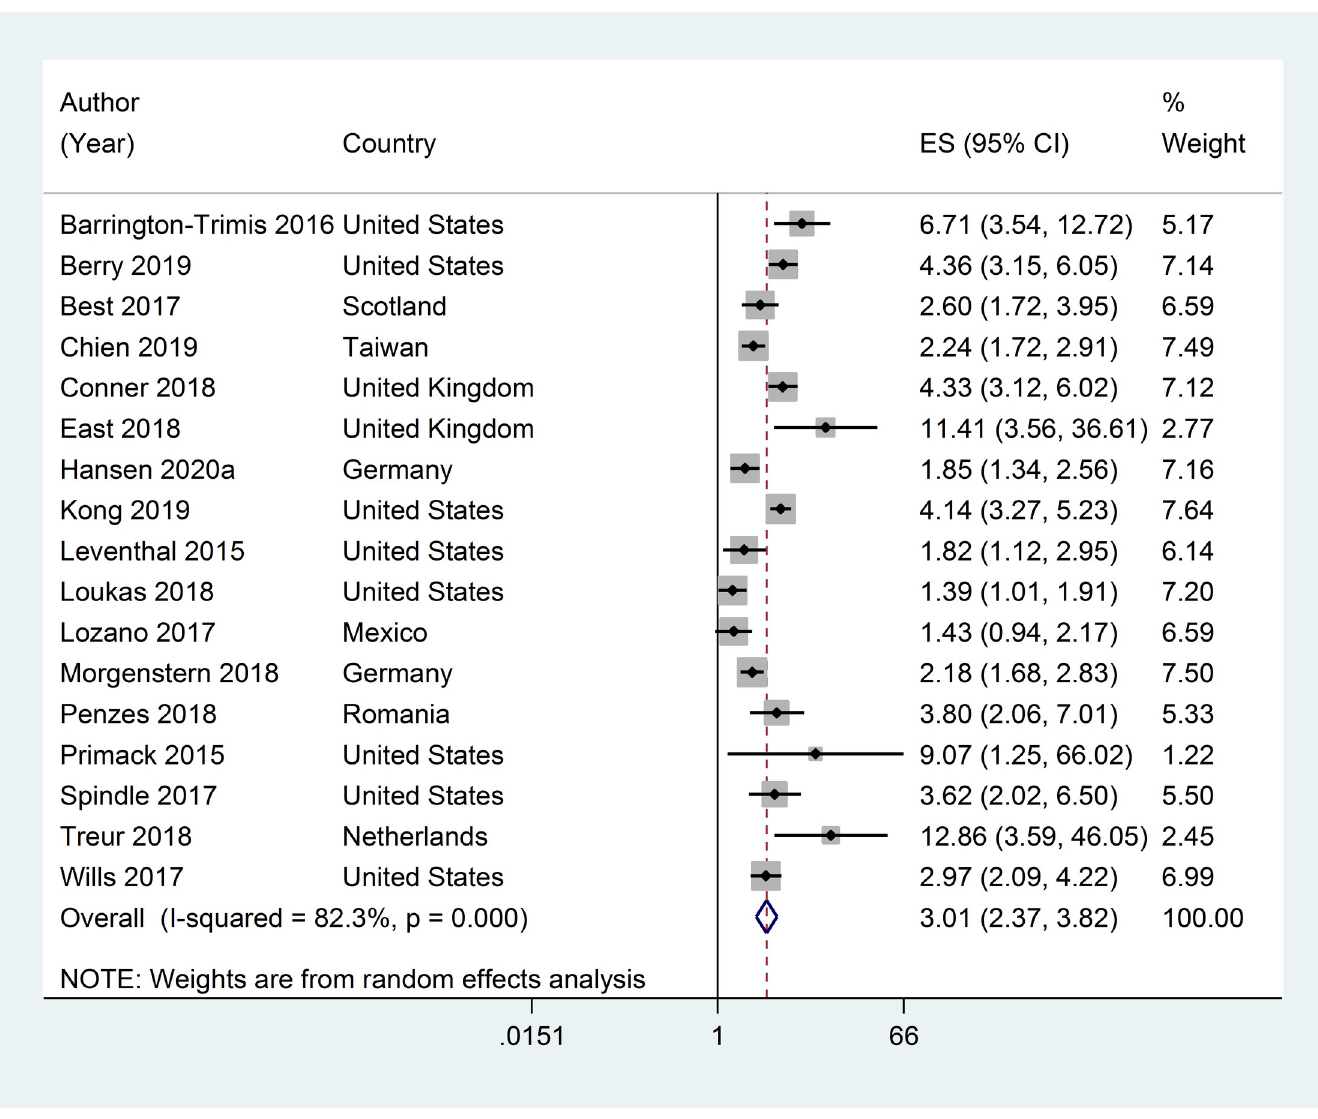
Fig 3. Forest plot of adjusted risk ratios assessing the association between ever e-cigarette use at baseline and subsequent ever cigarette use at follow-up.